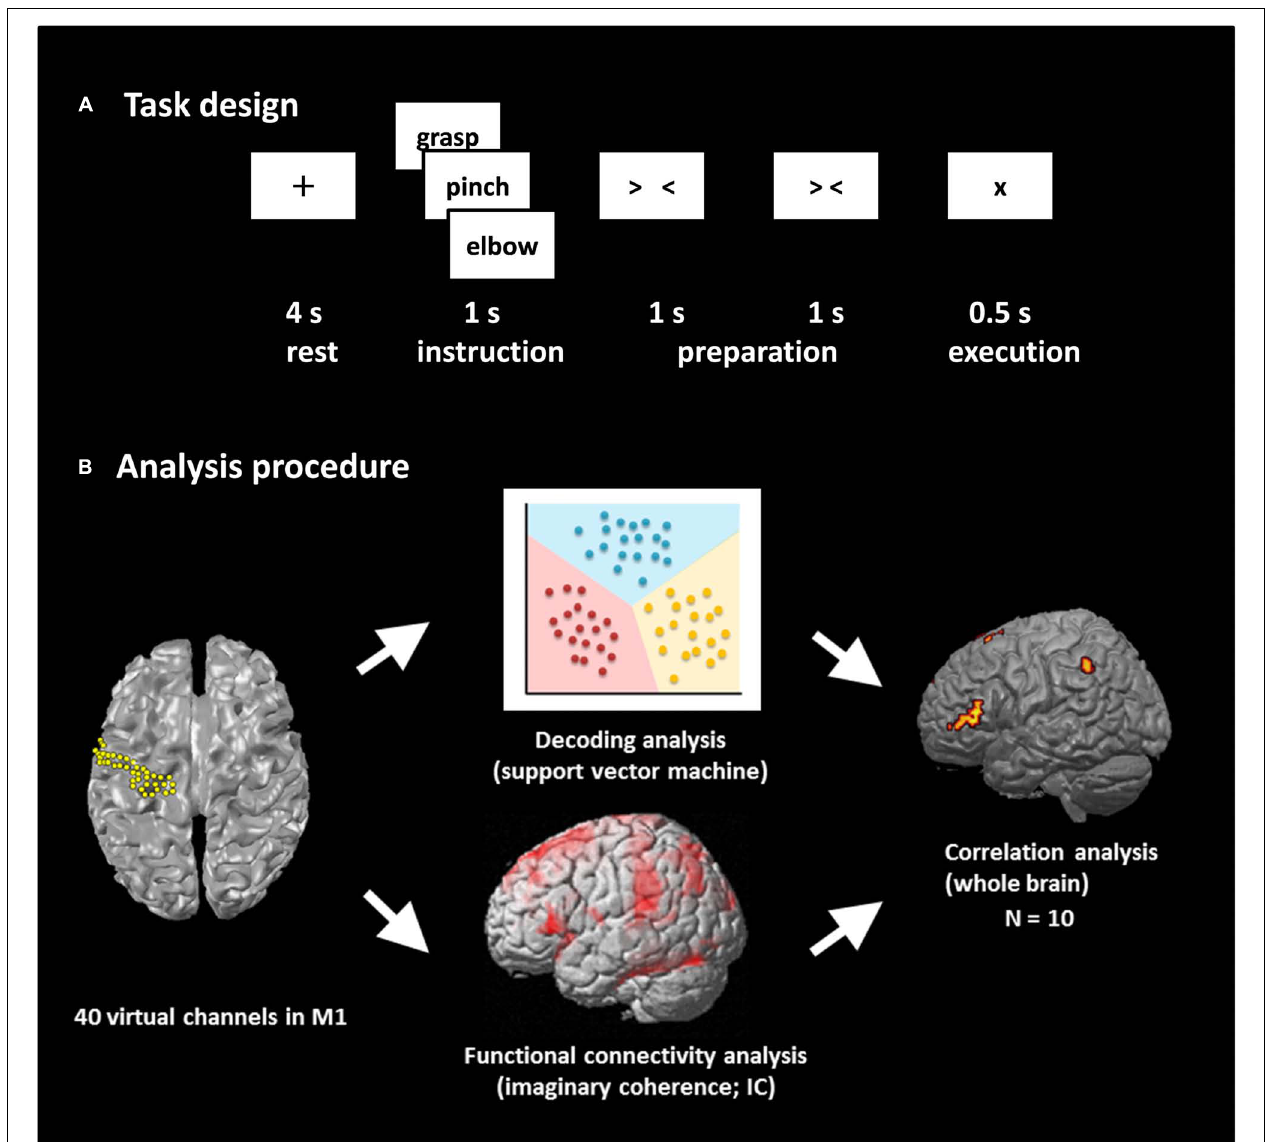
FIGURE 1 |Task design and analysis procedure. (A) Task design. Participants performed a real movement task and an imagined movement task following the same task paradigm. Each trial consisted of four phases: a rest phase, an instruction phase, a preparation phase, and an execution phase. In the rest phase, participants fixed their eyes on a black fixation cross “ + ” presented for 4 s. A Japanese word representing one of three movements was then presented for 1 s during the instruction phase. Then, two timing cues, “ > < ” and “ > < ,” were presented during the preparation phase to enable the participants to prepare the execution of real or imagined movements. Finally, the